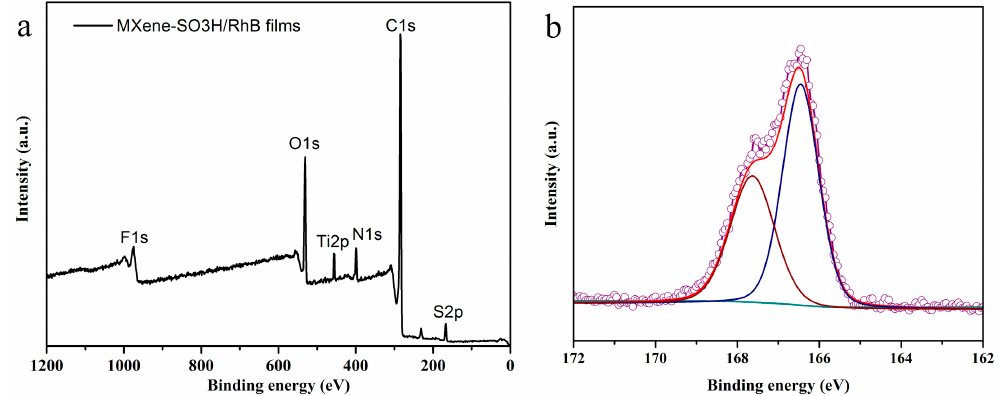
Figure 6. XPS profiles of the obtained MXene-SO3H/RhB composite films ( a ) and the S2p deconvolutions ( b ). Table 1. Atomic percentages of MXene-SO3H/RhB composite films from XPS measurement. Element C Ti F N S O Atomic percentage (%)